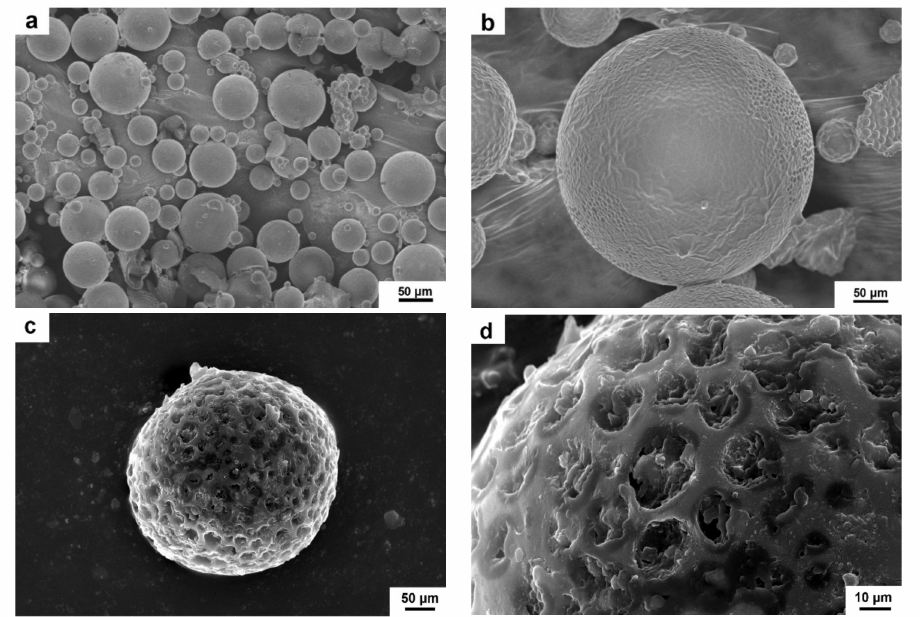
Figure 5. SEM images of sustained-release microcapsules ( a ); microcapsules after heating at 130 ◦ C ( b ); and microcapsules after heating at 140 ◦ C ( c , d